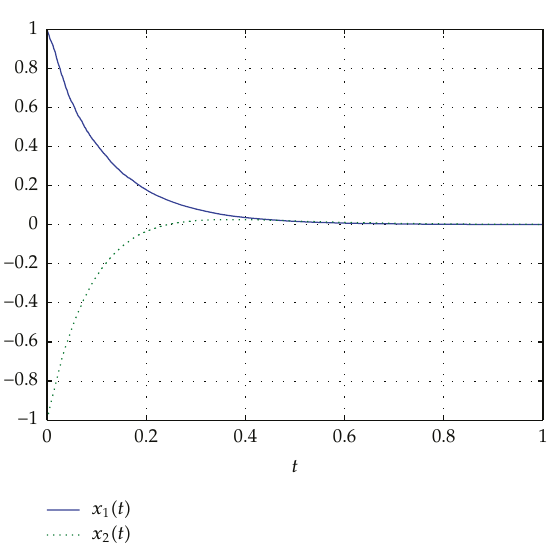
Figure 1: The state x 1 and x 2 of the closed-loop system in Example